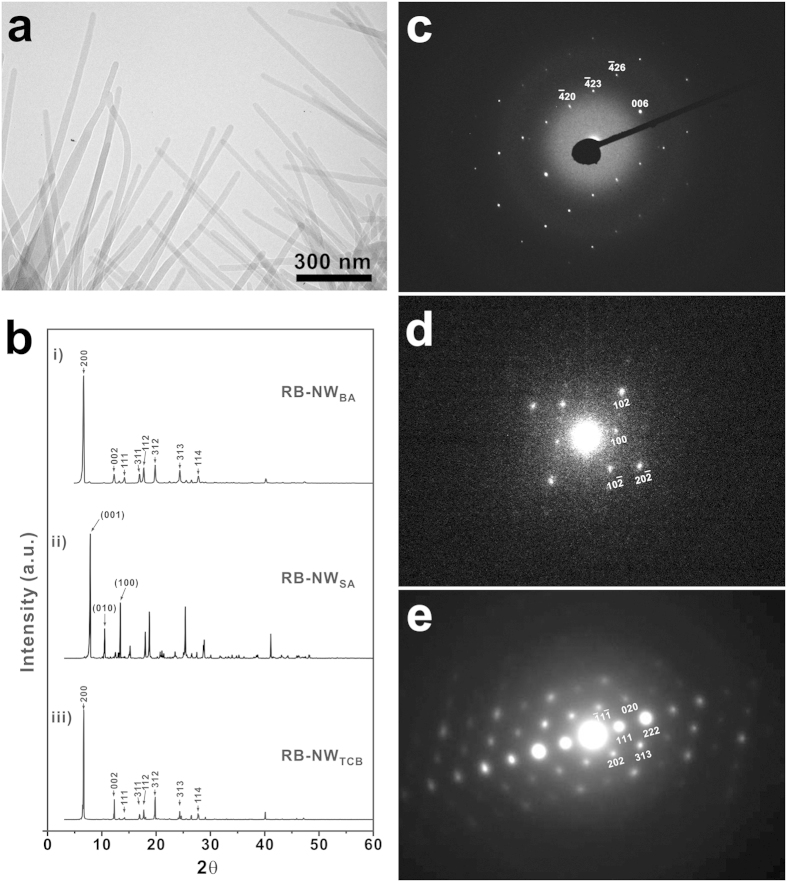
(a) A representative TEM micrograph of RB-NWBA prepared by eutectic melt crystallization on a several-gram scale. (b) XRD patterns of rubrene nanowires prepared by eutectic melt crystallization: i) RB-NWBA, ii) RB-NWSA, and iii) RB-NWTCB. The XRD patterns of RB-NWBA and RB-NWTCB were both consistent with the orthormbic structure (a = 26.86, b = 7.193, c = 14.433, α = β = γ = 90), and RB-NWSA was consistent with the triclinic structure (a = 7.02, b = 8.54, c = 11.95, α = 93.04, β = 105.58, γ = 96.28). SAED patterns of (c) RB-NWBA, (d) RB-NWSA, and (e) RB-NWTCB.